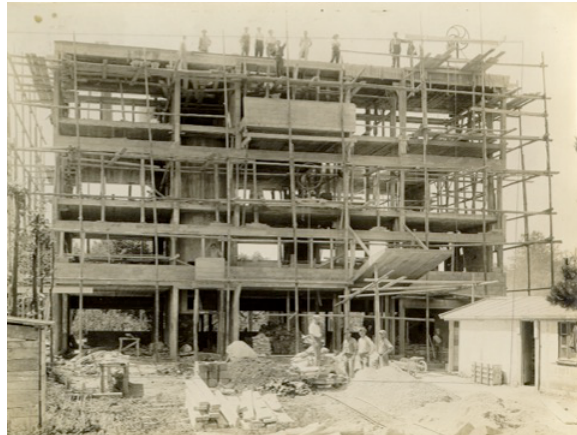
Figure 2. Northern façade, building site [FLC L1-10-8]